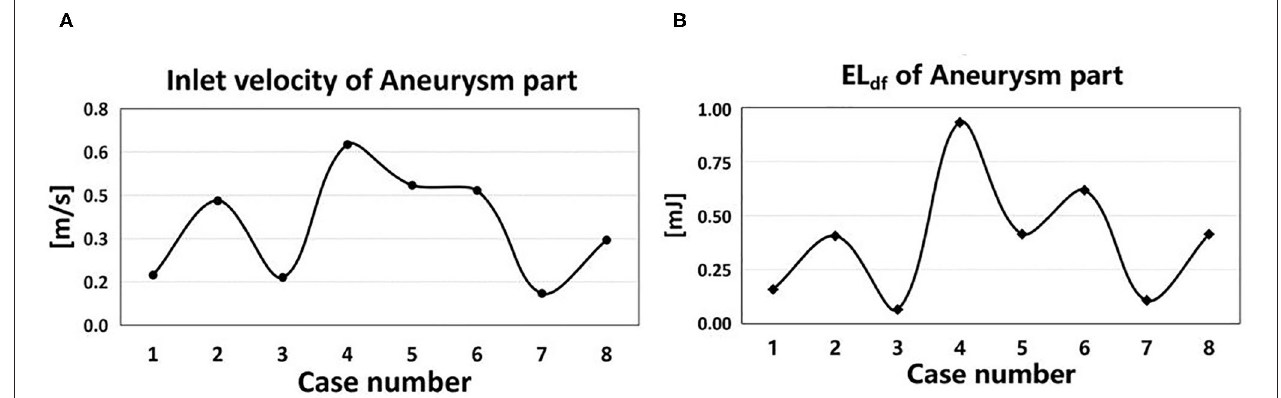
FIGURE 7 | EL of IAs with two different morphological characteristics. (A) Narrowing parent vessel has obviously higher DF. (B) Curving parent vessel upstream of aneurysm sac has higher DF.